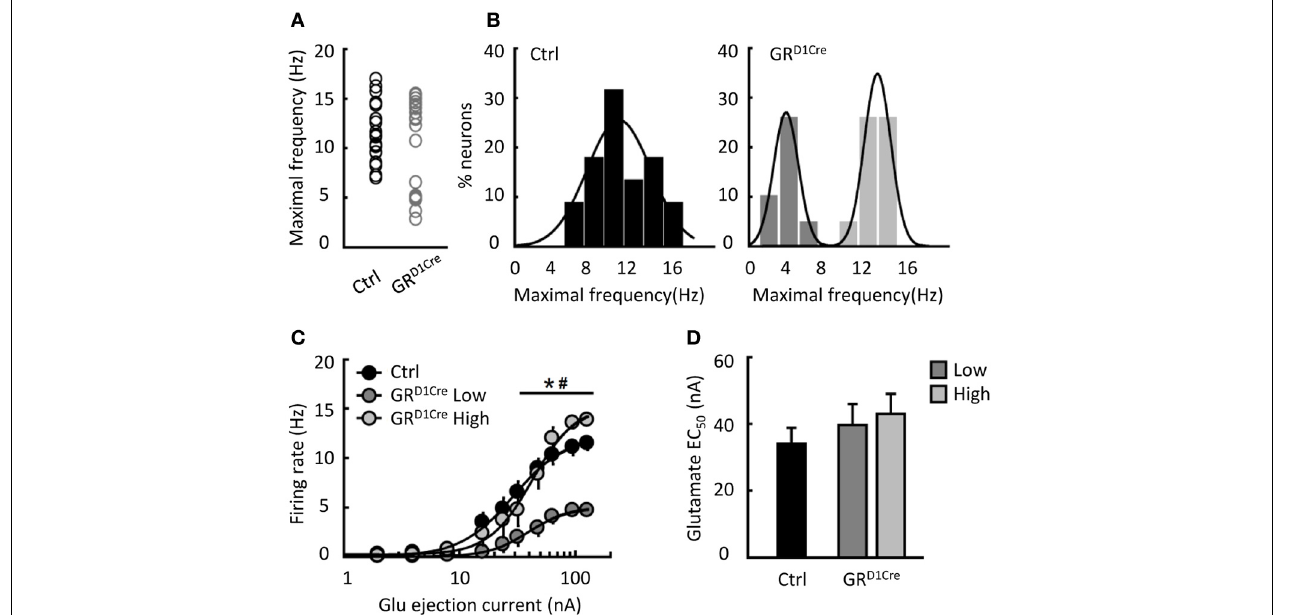
Glutamate dose response in NAc neurons from control mice (black bars) and in the two populations of NAc neurons found in GR D1Cre mice. Slow-firing neurons recorded in GR D1Cre mice differed from the two other populations [dose population interaction F ( 20 , 390 ) = 5 . 47, p < 0 . 0001]. ∗ P < 0 . 001 for GR D1Cre slow vs. GR D1Cre high, # P < 0 . 001 for GR D1Cre slow vs. control. (D) The EC 50 of the 3 populations of neurons did not differ [ F ( 2 , 39 ) = 0 . 72, p = 0 .